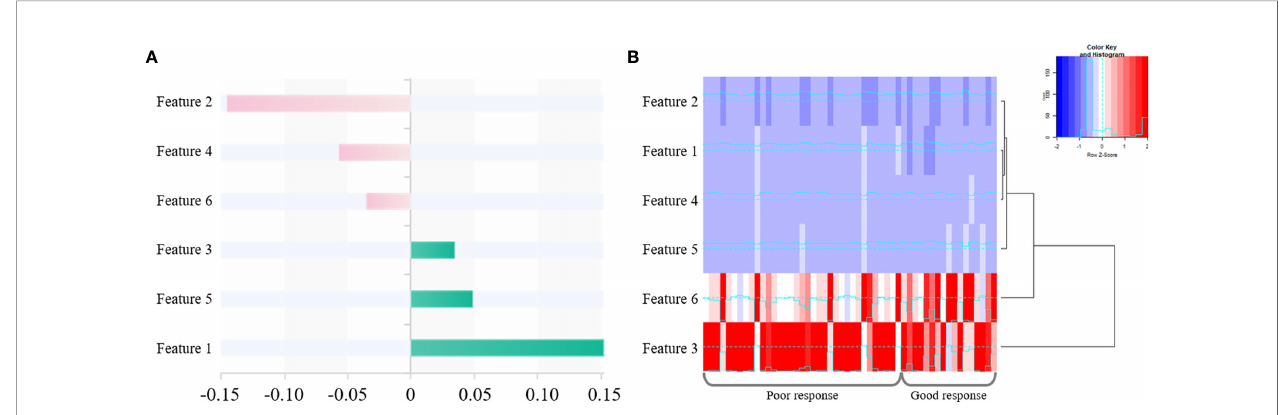
FIGURE 4 | The selected six radiomics features. (A) Coef fi cients in the LASSO model. (B) A cluster analysis chart showing values for various radiomics features calculated for different responses to nCRT.